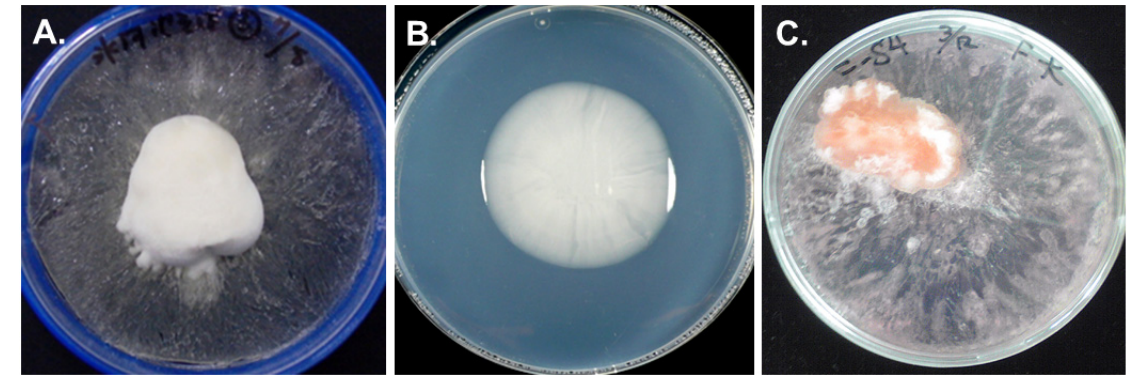
Figure 2. Colonies of G. antarctica at subzero temperature. Soil near Hyoga-Ike (glacier pond) in Landvode was inoculated on frozen PDA at − 1 °C for 3 months ( A ). S4B strain was isolated from soil in East Onglu Is. Their growth on unfrozen PDA at − 1 °C for 1 month ( B ) and frozen PDA, including red food coloring for 2 months ( C ).